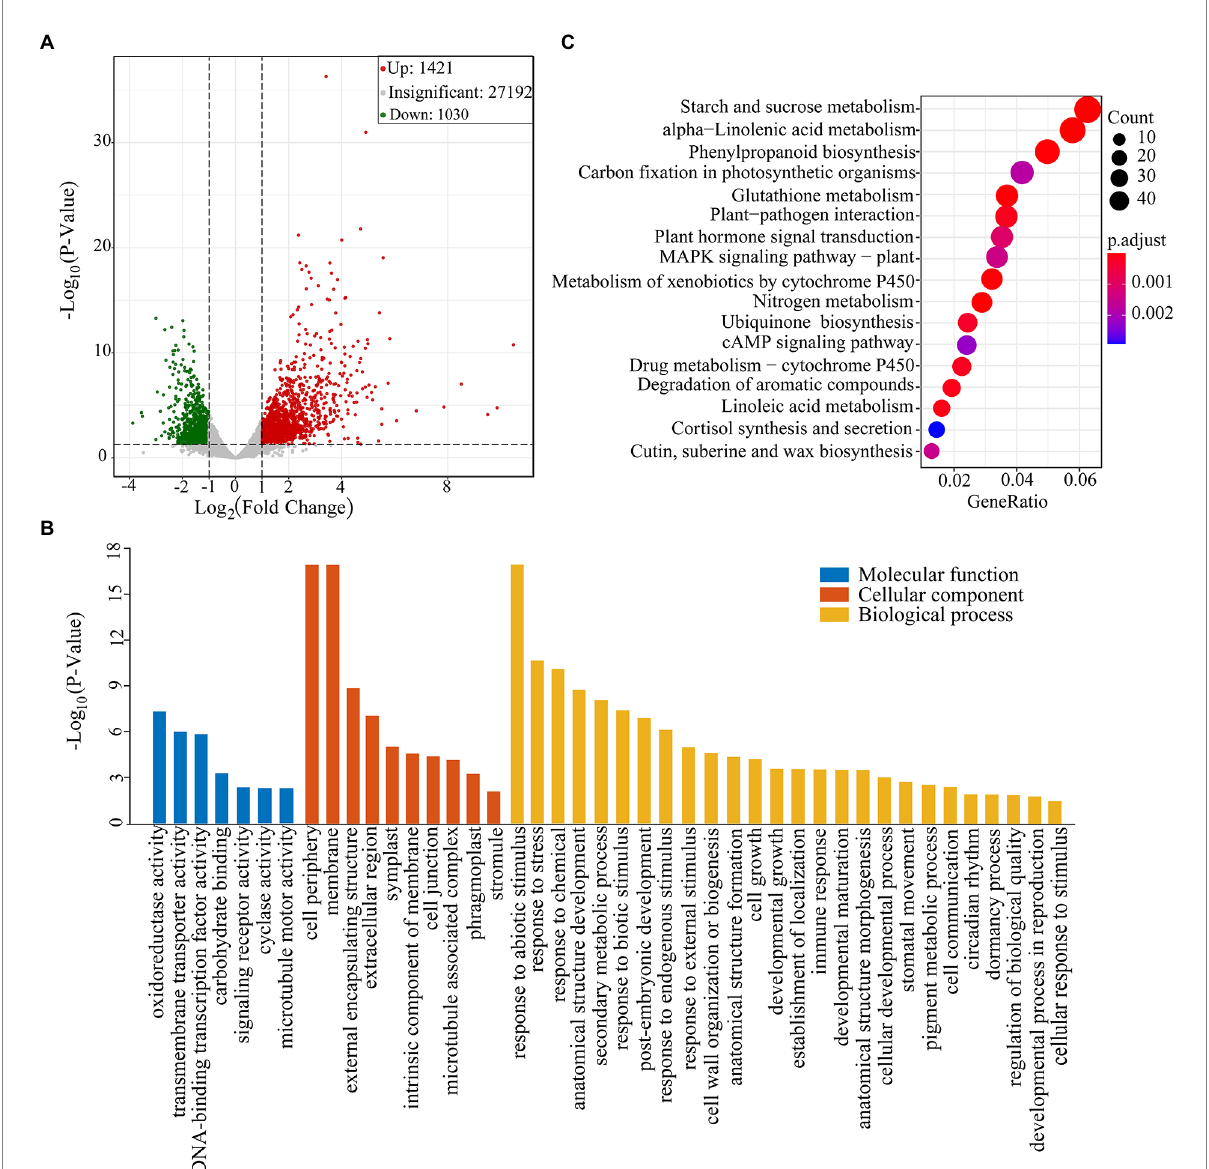
FIGURE 2 Transcriptome sequencing analysis of Pohlia nutans under drought stress. (A) Volcano plot of differentially expressed genes (DEGs) in CG and PEG-treated groups. Each point in the figure represents a gene. Green dots represent downregulated genes, red dots represent upregulated genes, and gray dots represent genes detected but not significantly different. (B) GO enrichment analysis of DEGs. (C) KEGG pathway enrichment of DEGs. Gene ratio represents the ratio of the number of DEGs to the total number of annotated genes in this